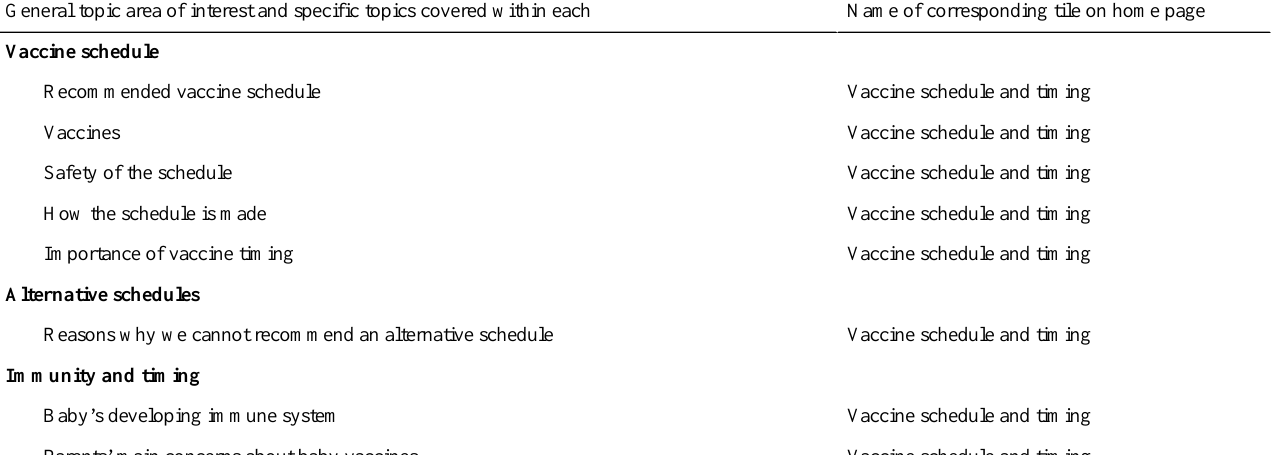
Table 2. Topic areas (general tops: n=17; specific topics: n=41) covered in the intervention and corresponding tile on the home page